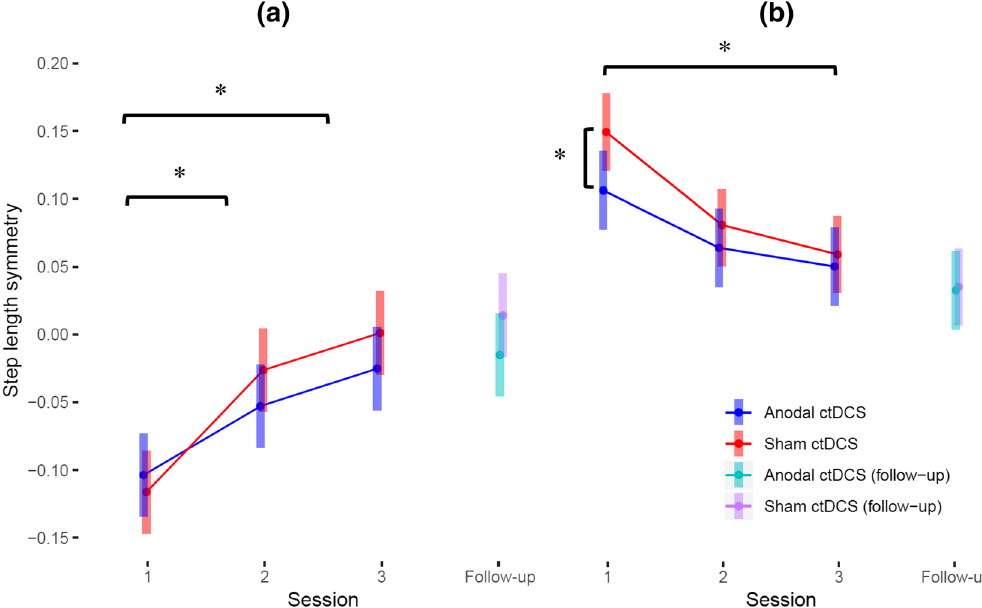
Figure 9. Comparison of mean estimates and 95% confidence intervals between groups over the four sessions for ( a ) immediate adaptation and ( b ) immediate